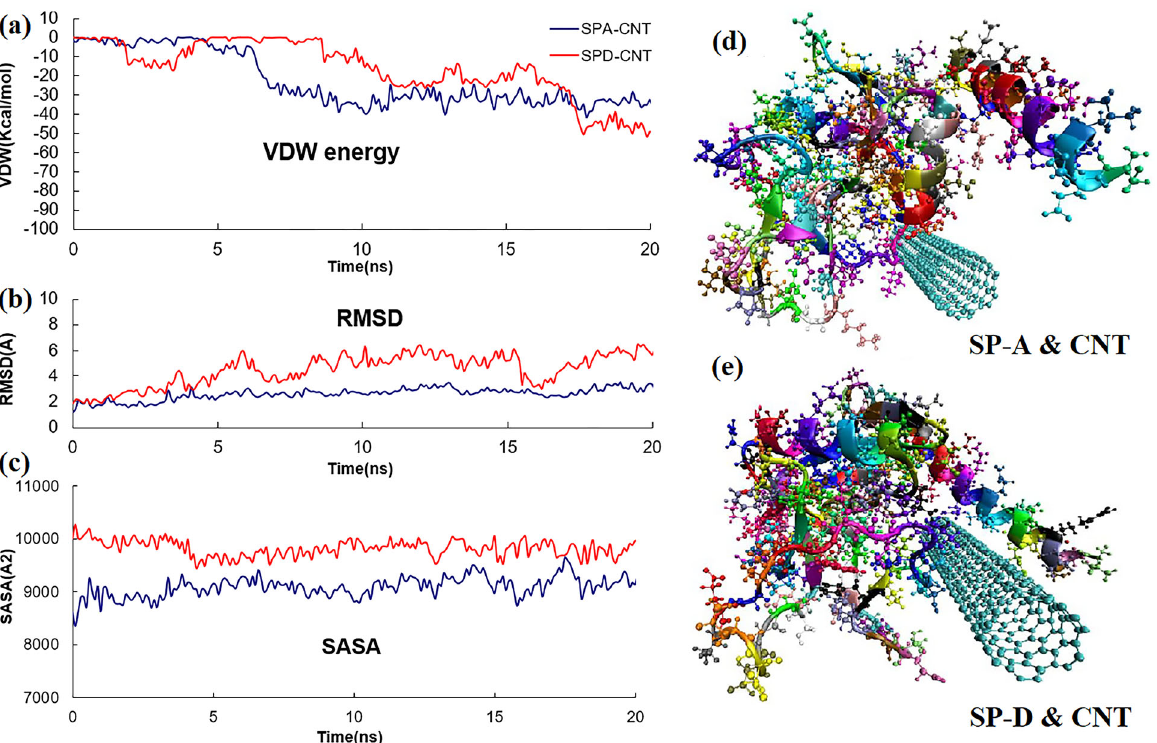
Figure 1. (a) VDW energy between SP-A, SP-D, and CNT; (b) RMSD of SP-A and SP-D protein backbone in the presence of CNT; (c) SASA of SP-A, SP-D in the presence of CNT; (d) molecular dynamic model for pulmonary surfactant protein SP-A and